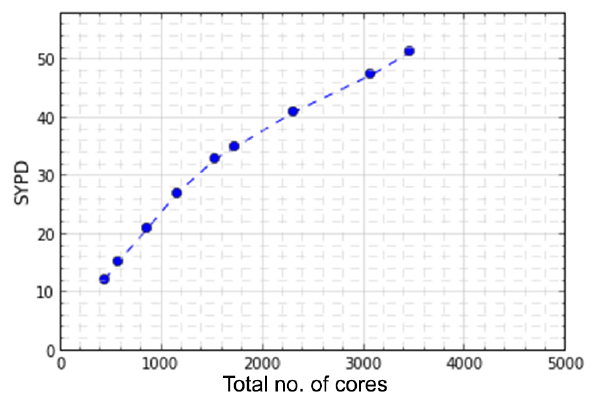
Figure 3. Scaling behaviour of a GFDL model. It illustrates that the model could be run at 50SYPD in capability, or speed mode, but in practice is most often run at the shoulder of the curve, at around 35SYPD, which gives the best